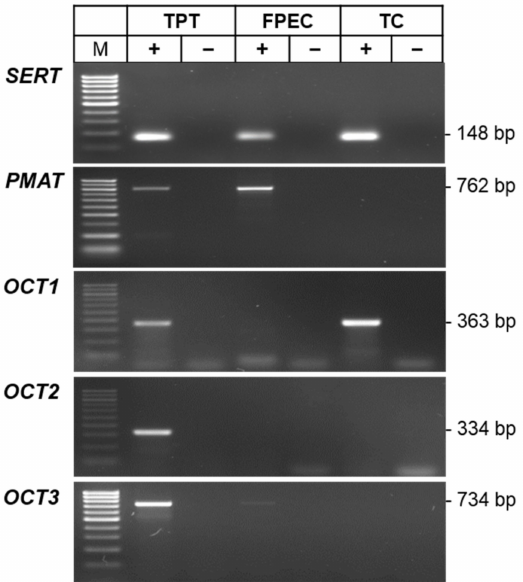
Figure 3. Conventional end-point RT-PCR analysis of serotonin transporter ( SERT ), plasma mem- brane monoamine transporter ( PMAT ), organic cation 1 ( OCT1 ), 2 ( OCT2 ), and 3 ( OCT3 ) mRNAs in pooled samples of human primary trophoblasts (TC; n = 9) and feto-placental endothelial cells (FPEC; n = 12). The total placental tissue (TPT; a pool from 20 individuals) served as a positive control.